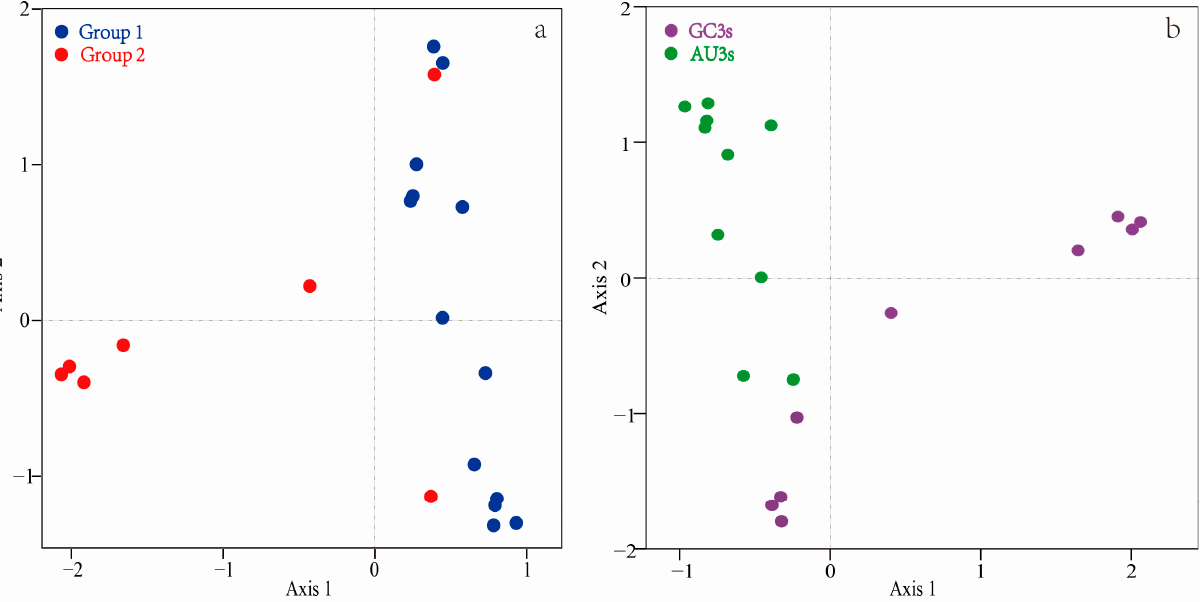
Figure 6. Multidimensional preference analysis of the relative synonymous codon usage for each codon of the 20 XET genes. 2.3. Base Composition Affects the Formation of Codon Usage Bias